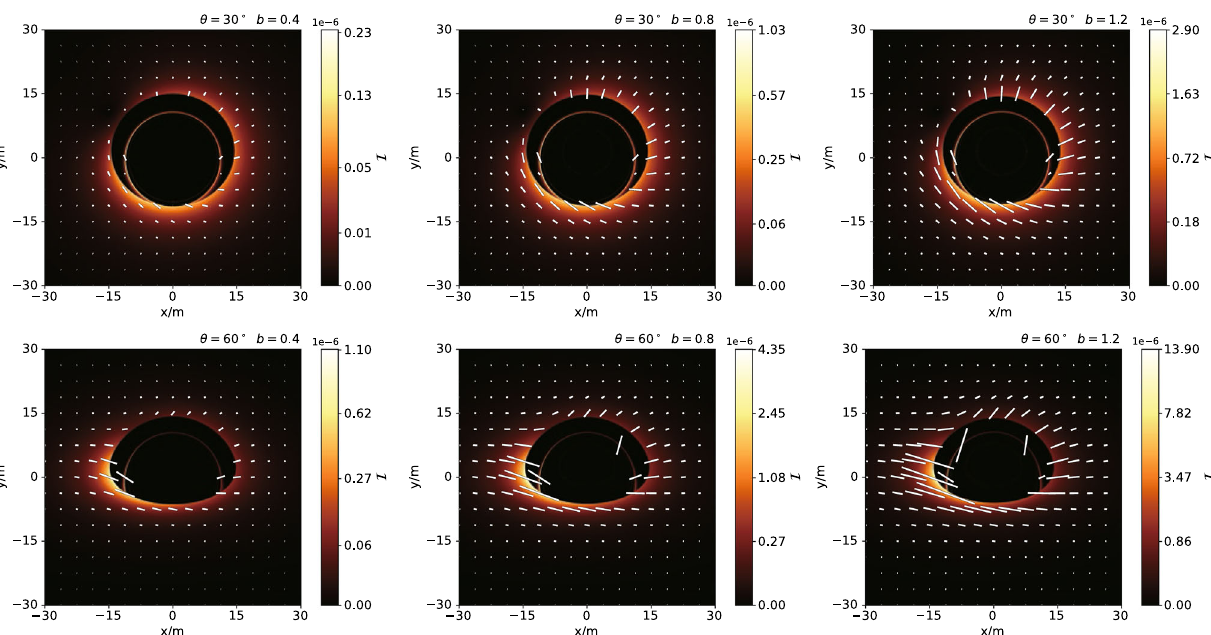
Fig. 6 Polarized image of Bonnor black dihole arising from the synchrotron radiation with different b and θ 0 . The observed linear polarization vectors are shown by the white lines Fig. 7 Polarized image of Schwarzschild black hole with the same magnetic field distribution as that of Bonnor black dihole with parameter b = 0 .